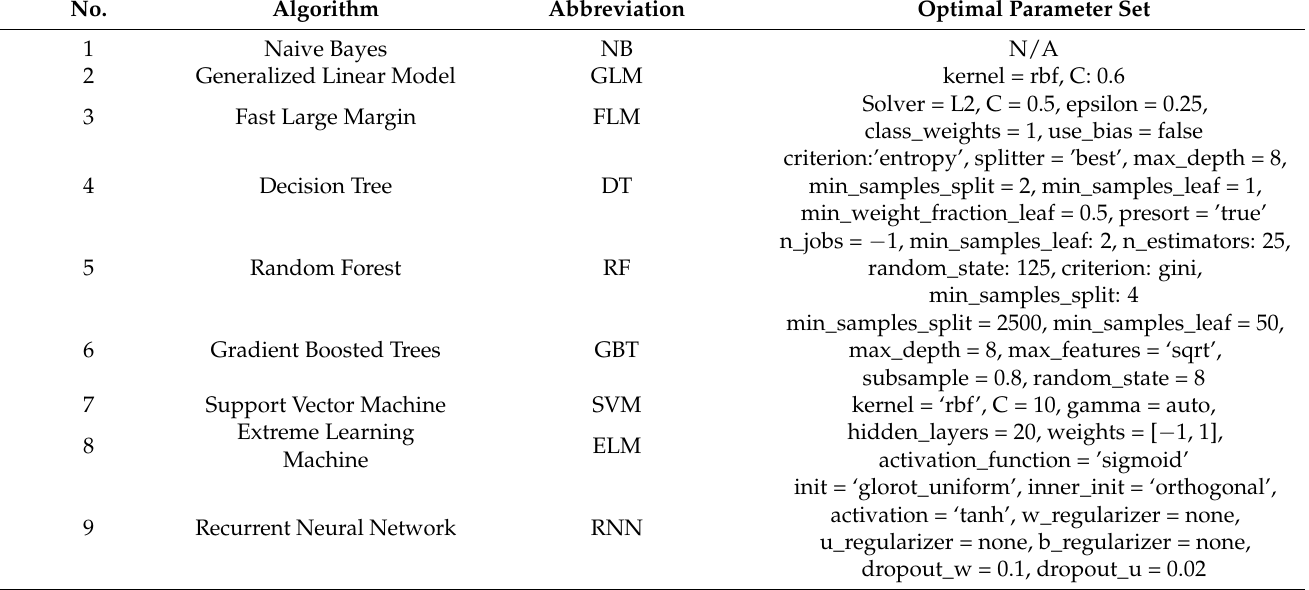
Table 7. Selected ML algorithms with their optimal parameter